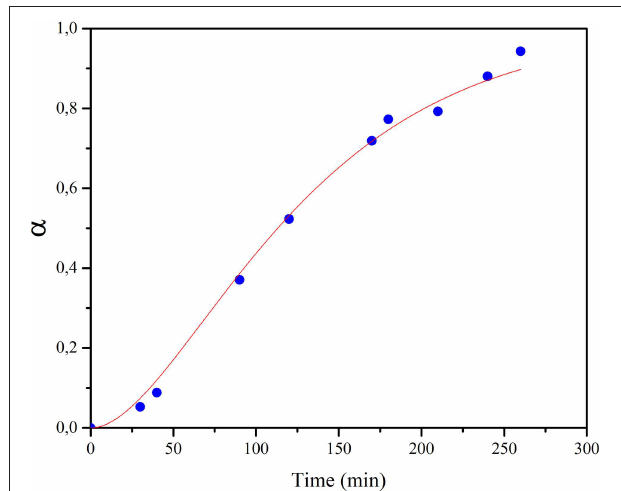
FIGURE 3 | Methane concentration values in the gas phase mixture, reported as degree of conversion α , as a function of mechanical treatment time, t . Blue dots refer to experimental data, while continuous line represents the fitting curve according to the empirical equation reported in the